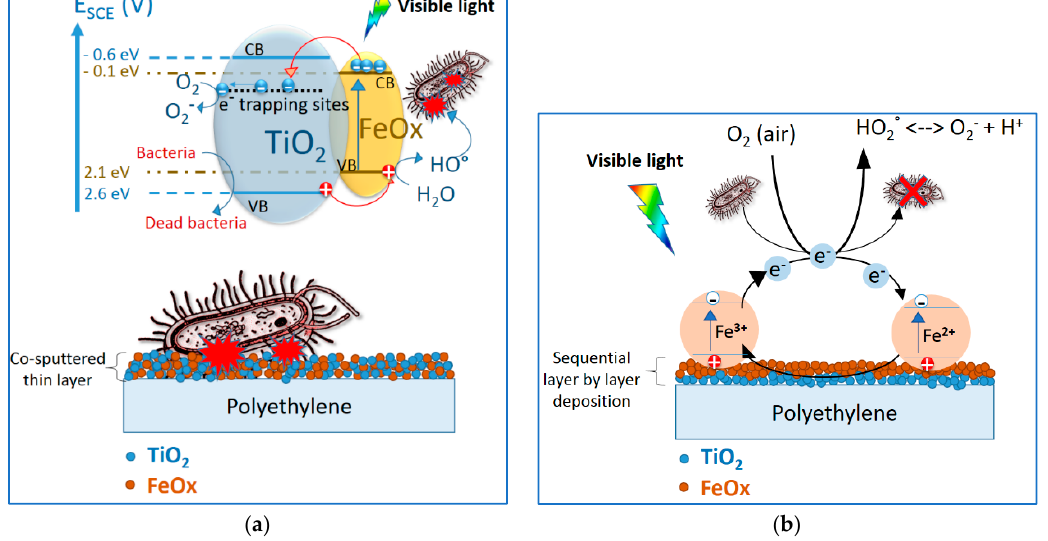
Figure 8. ( a ) IFCT leading to bacterial inactivation under visible light induced by co-sputtered by TiO 2 –FeO x –PE films. For further details, see the text. ( b ) Simplified mechanism for bacterial inactivation by sequentially sputtered TiO 2 /FeO x –PE films under visible light. For further details, see the text.